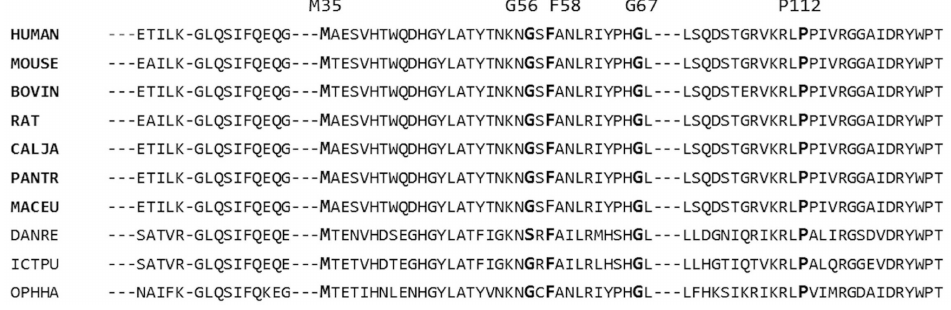
Figure 2. Sequence alignment of SpmSyn among different species. The mutation sites considered in this study are represented in bold letters and the position of the residue in human SpmSyn is shown at the top. The mammals considered in this study are represented in bold letters. Multiple sequence alignment (MSA) is performed with Cobalt Constraint-based Multiple Protein Alignment Tool